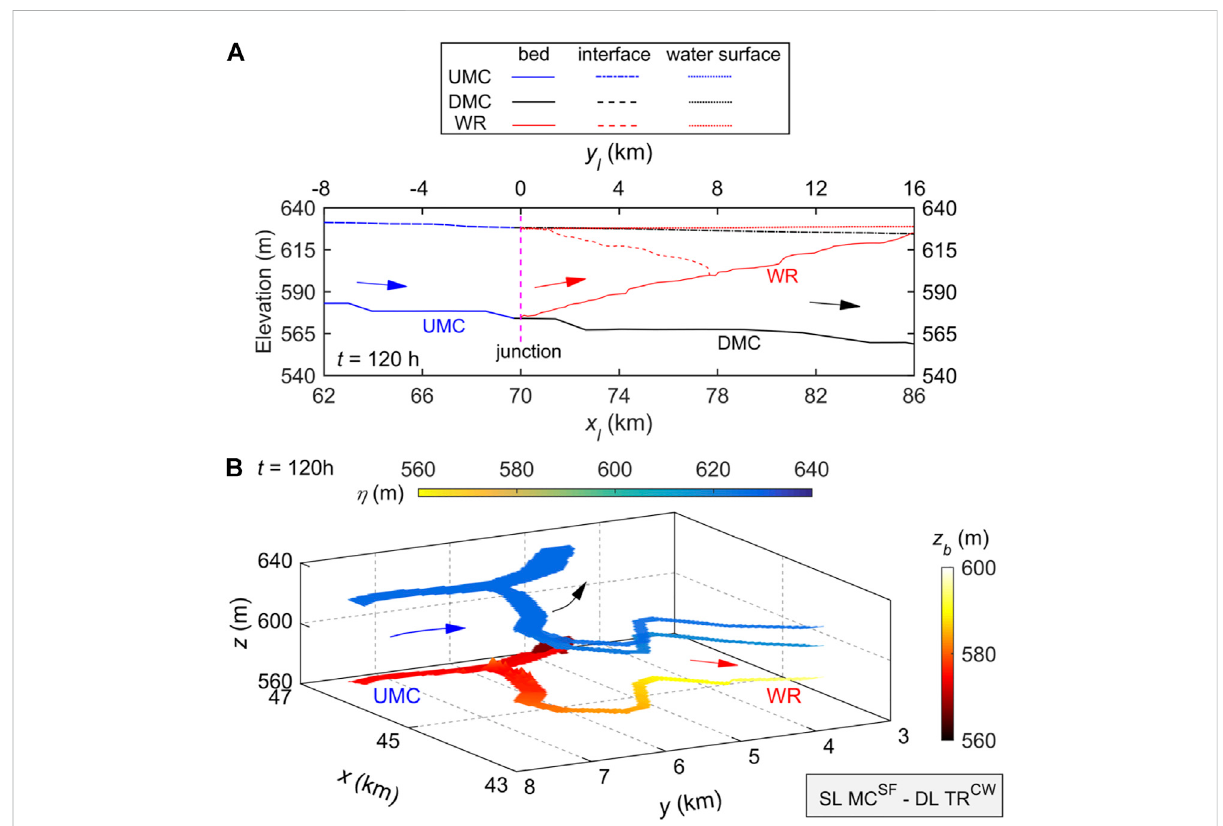
FIGURE 11 Vertically SL MC SF — DL TR CW within the con fl uence of MC (Yellow River) and WR (Wuding River) for Case G1 at t = 120 h, where UMC and DMC denote upstream and downstream of the MC con fl uence: (A) water surface elevation, interface, and bed pro fi les along the thalweg, and (B) three- dimensional layered fl ow